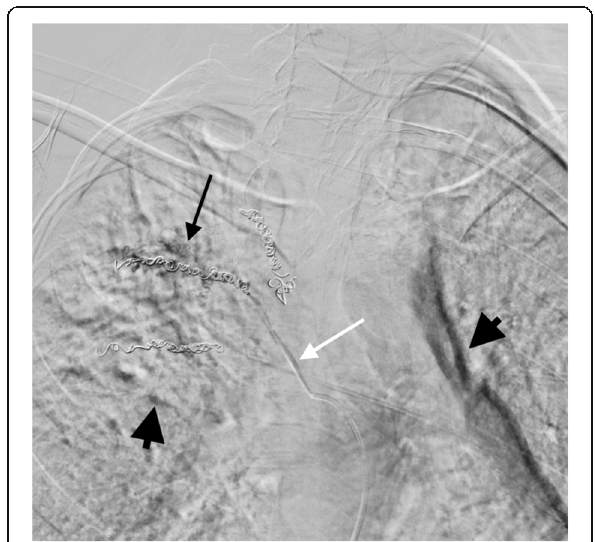
Fig. 2 Slight RAO projection of digital subtraction arteriogram during attempted microparticle infusion with evidence of reflux along the microcatheter located in the fourth intercostal artery (white arrow). There is some minor, incomplete filling of the tortuous, ectatic vessels distal to the coils (black arrow). Large black arrowheads demonstrate breathing artifact from digital subtraction